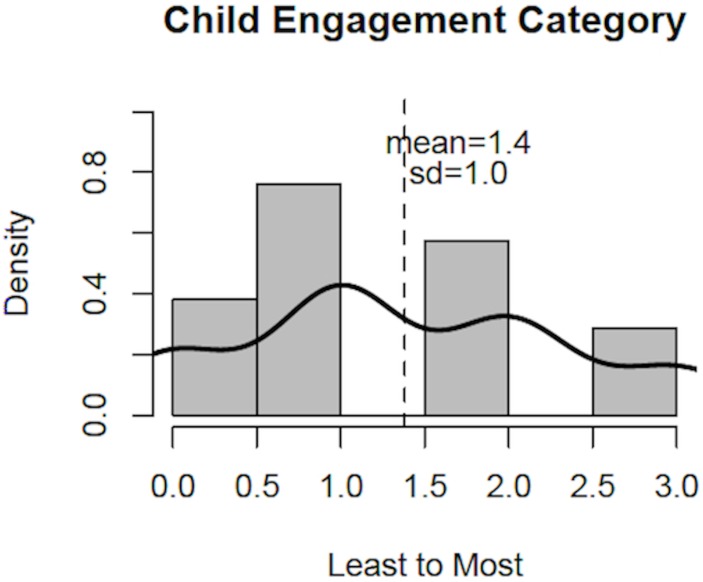
Observed child engagement scores.Histogram and density curve for observed child engagement scores, including mean (dashed line) and standard deviation (sd). Total score for each child was the mean of 3 reviewer scores.